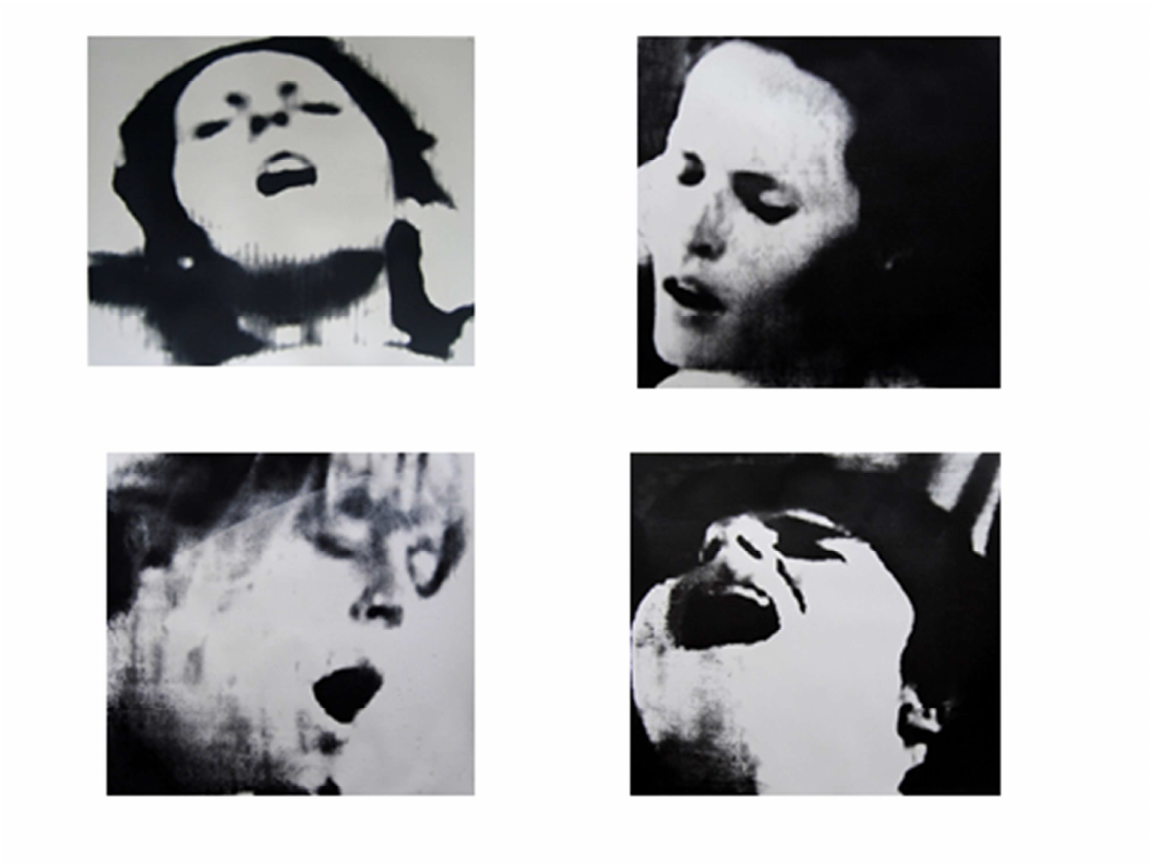
Figure 2-5: Helen Knowles 2011 ‘Heads of Women in Labour’: Youtube screengrab ‘Chase Andrews waterbirth’, Youtube screengrab Annabel’s birth, Youtube screen grab of ‘Shiloh’s quick and peaceful waterbirth’, Youtube screen grab German birth video, ‘Chase Andrews waterbirth’, all 61cm x 61cm, Screen prints of Fabriano. Reproduced with the permission of the